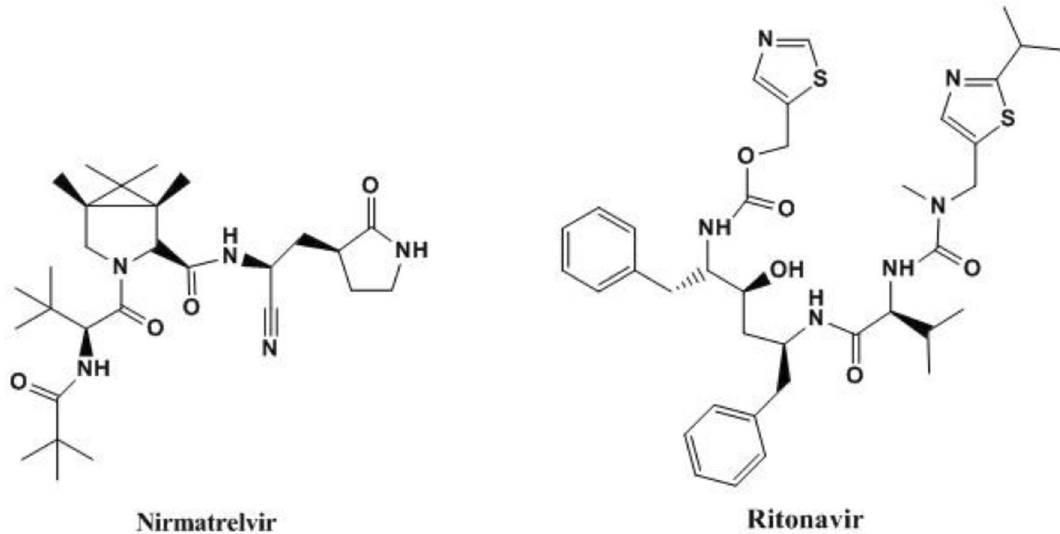
Figure 1. Structural formula of nirmatrelvir and